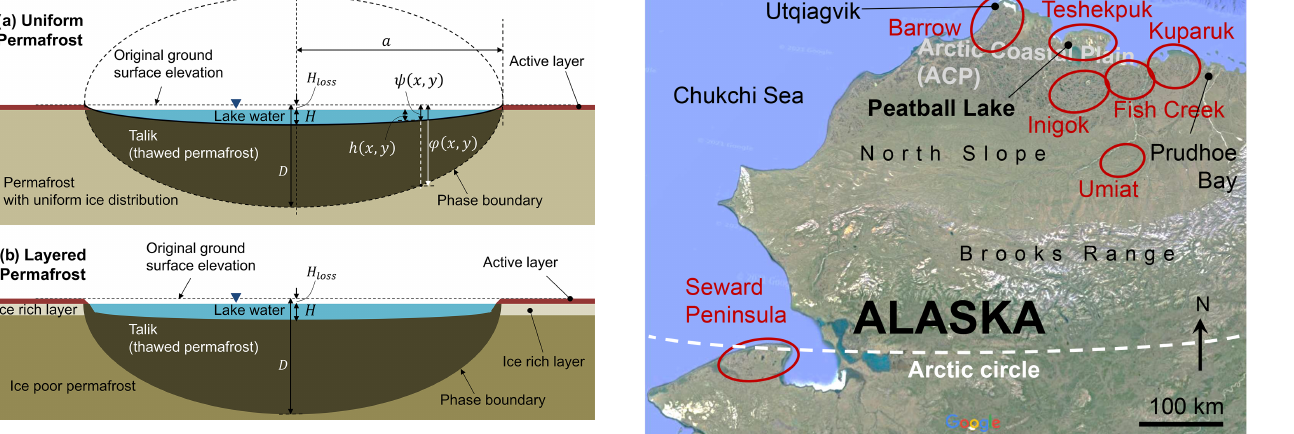
Figure 3. Map of the study area: Peatball Lake and subregions for lake characterization